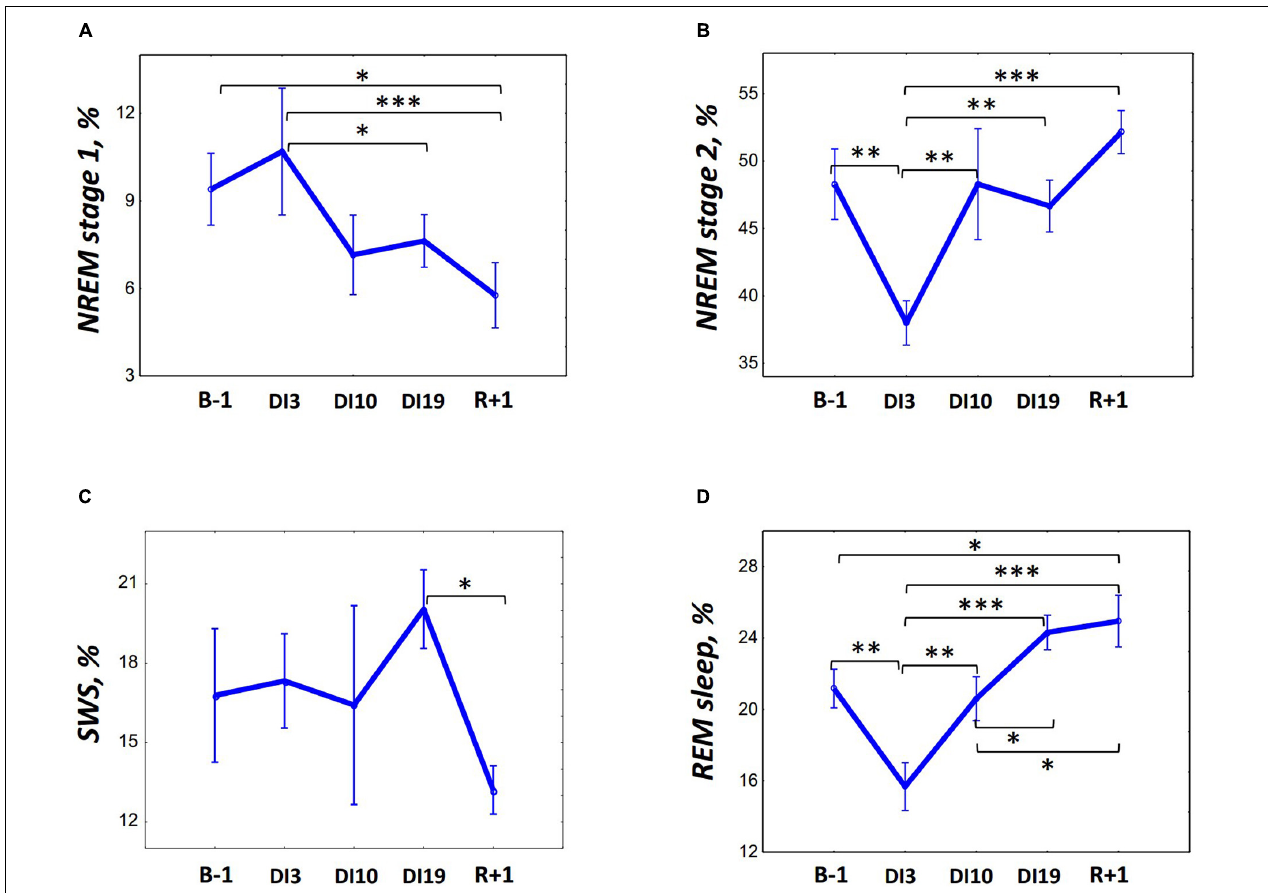
FIGURE 1 | Changes in the sleep architecture characteristics during 21-day Dry Immersion and recovery from it. (A) NREM stage 1, stage 1 of non-rapid eye movement sleep. (B) NREM stage 2, stage 2 of non-rapid eye movement sleep. (C) SWS, slow-wave sleep. (D) REM, rapid eye movement sleep. B-1, the day before dry immersion, DI3, DI10, DI19, on the 3rd, 10th, and 19th days of dry immersion, respectively, R + 1, 1 day after the end of dry immersion. The data presented are a percentage of the sleep period time, means ± SEM. Intersession differences were examined using the post hoc Fisher LSD test. ∗ , ∗∗ , ∗∗∗ represent significance p < 0.05, p < 0.01, p < 0.001, respectively. Photo of the volunteer during the ambulatory blood pressure monitoring and polysomnography recording in 21-day Dry Immersion. Photo by O.G. Voloshin